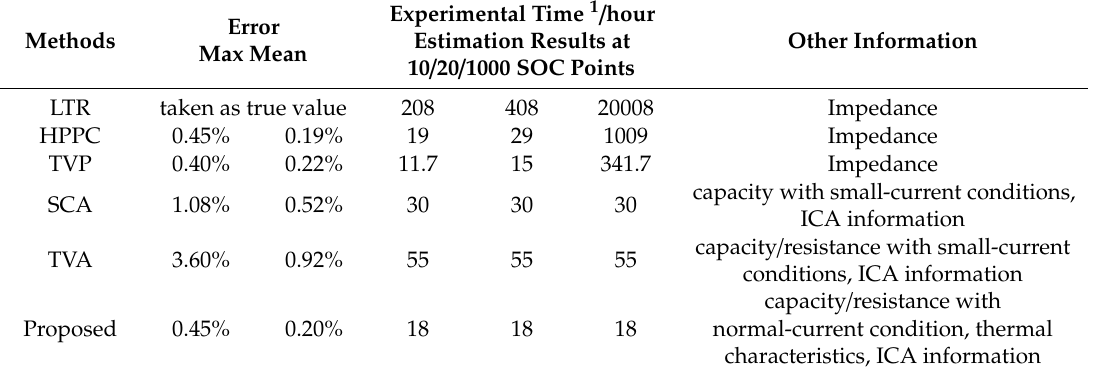
Table 3. Comparisons between di ff erent